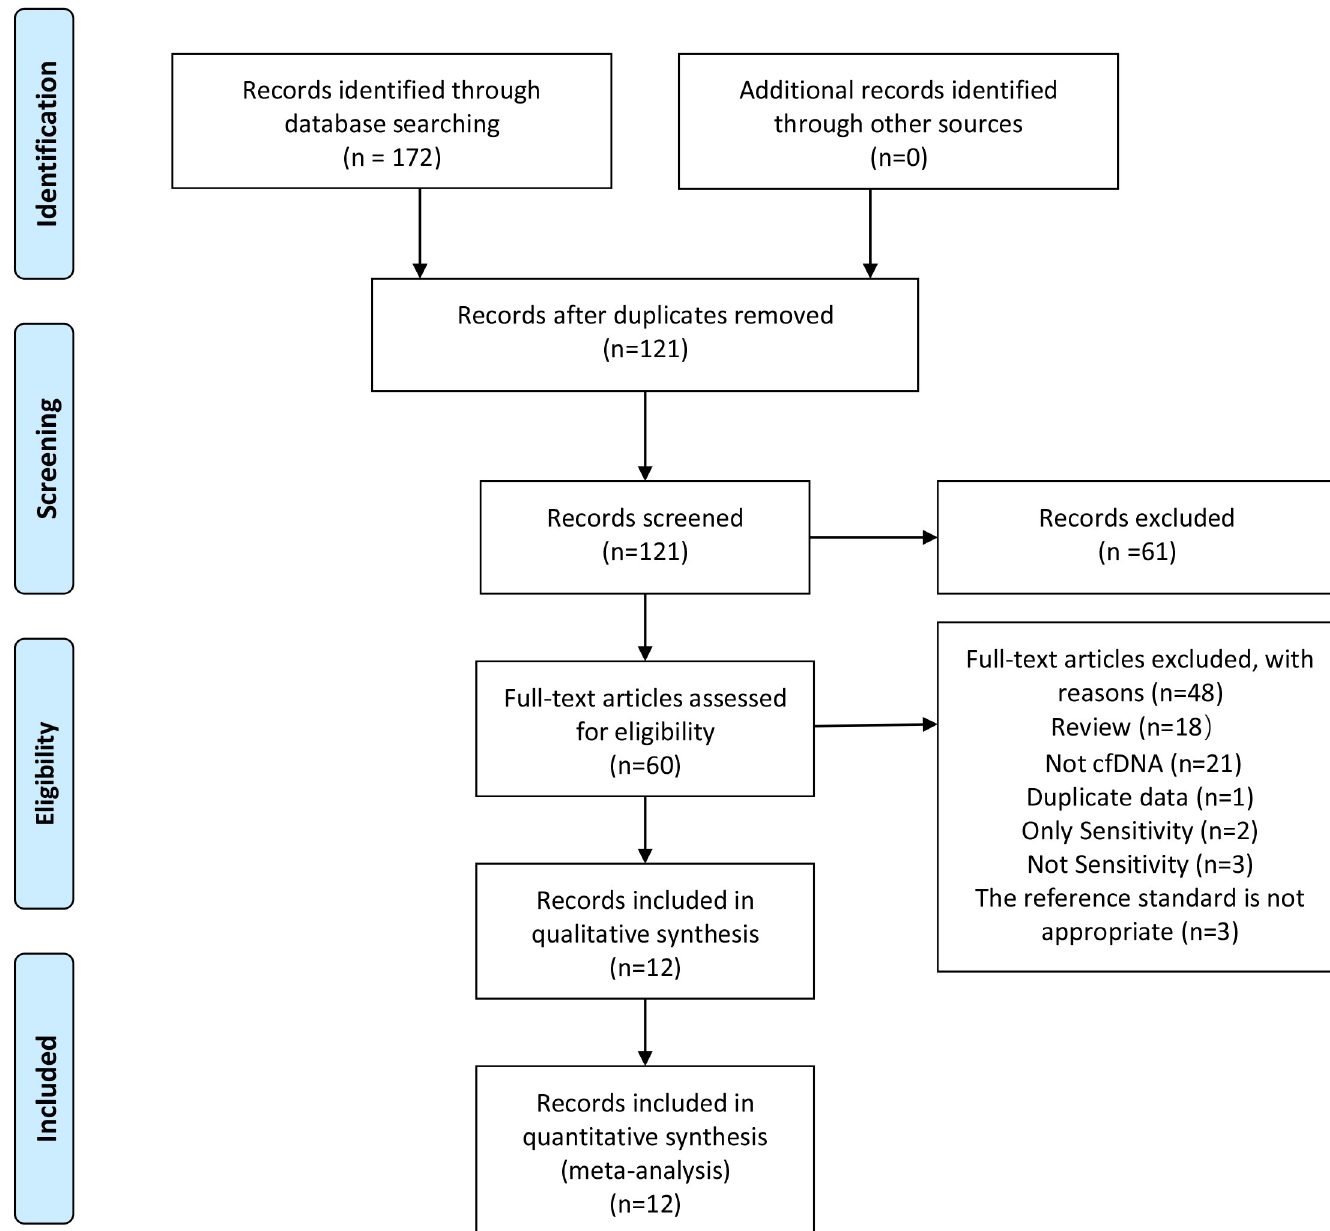
Fig 1. Flow chart of literature retrieval. cfDNA, cell free